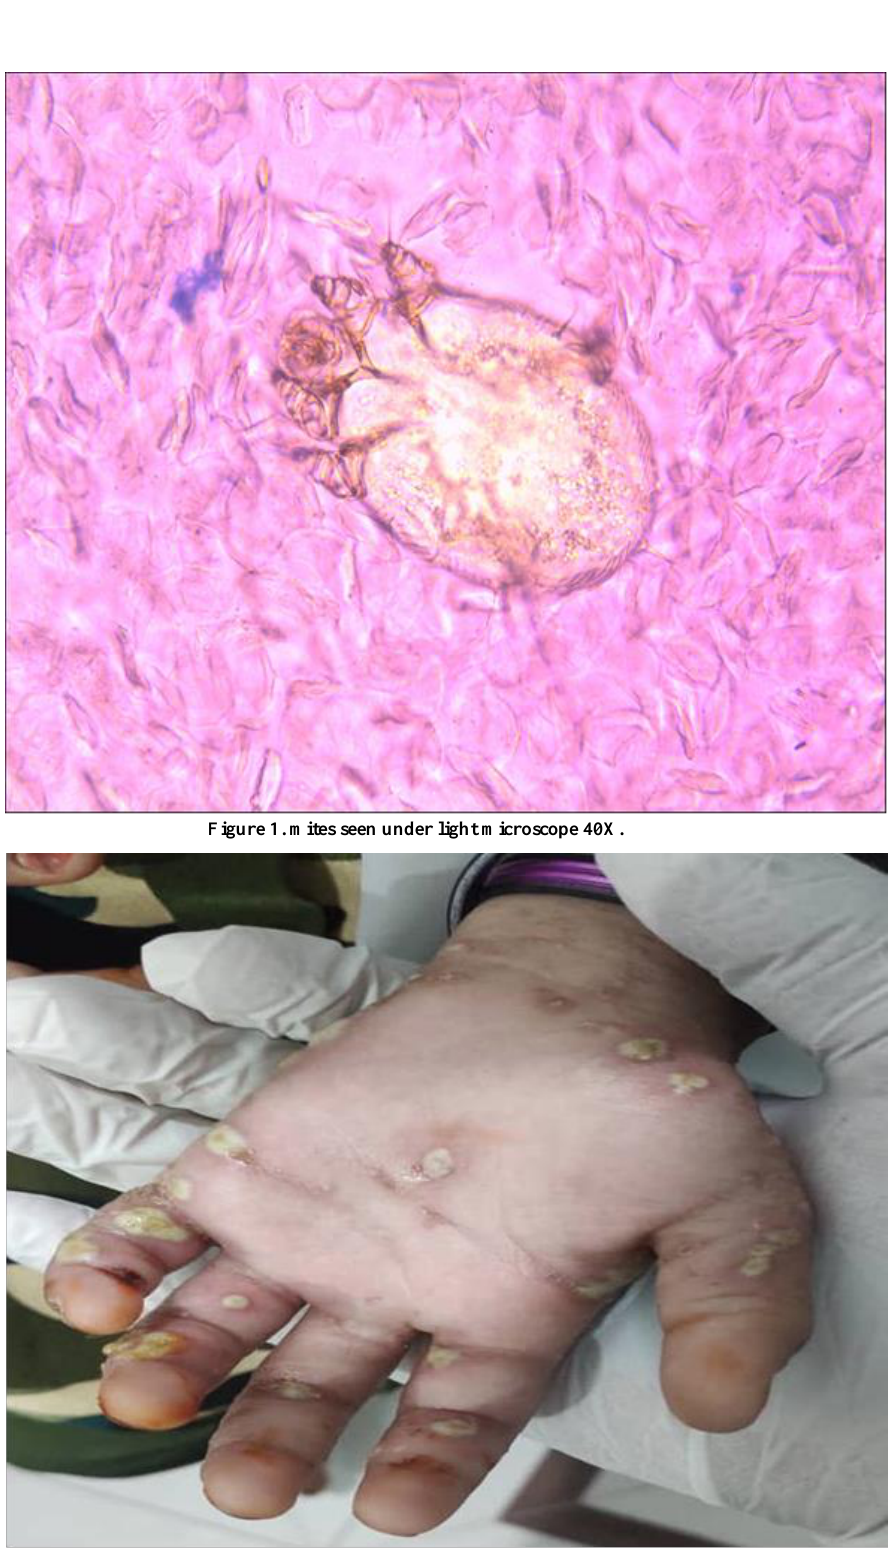
Figure 2. Pustules and papulovesicles on